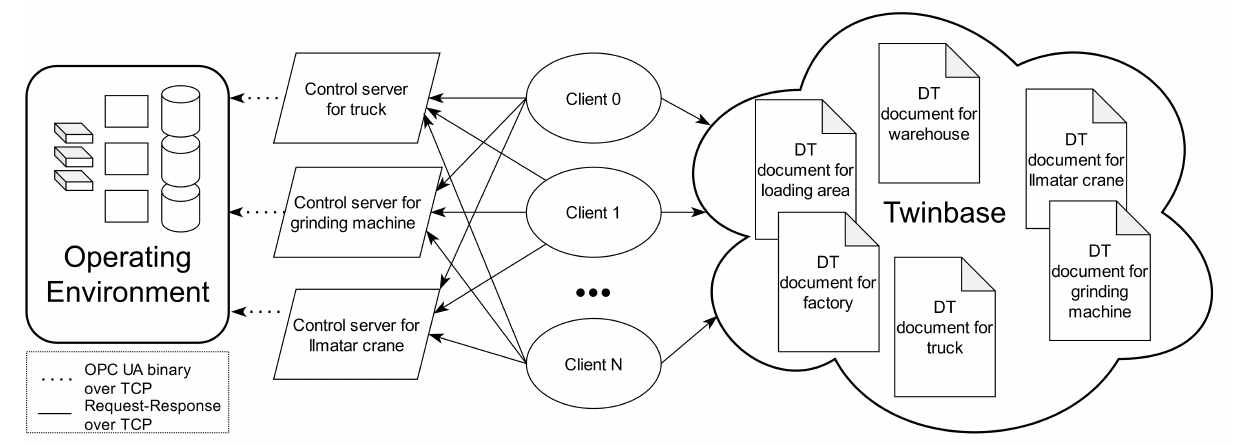
Figure 4. In the decentralized client-server control implementation, N number of clients together control the factory by sending commands to machines, but the clients do not communicate with each other. The arrows indicate the direction in which communication can be initiated, but data can still flow in both directions.